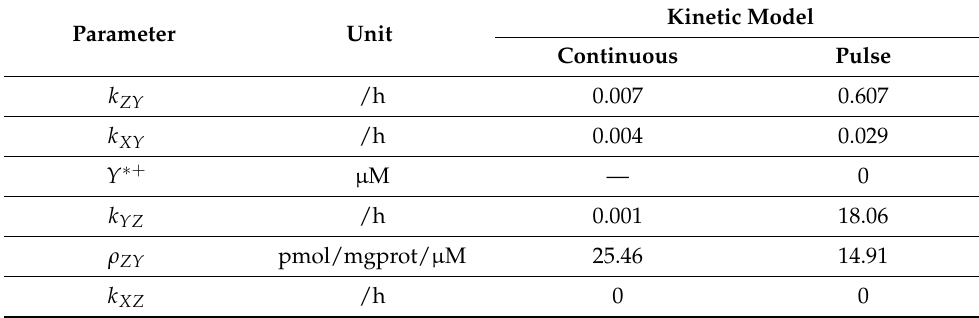
Table 2. Zoledronate kinetic model parameters.